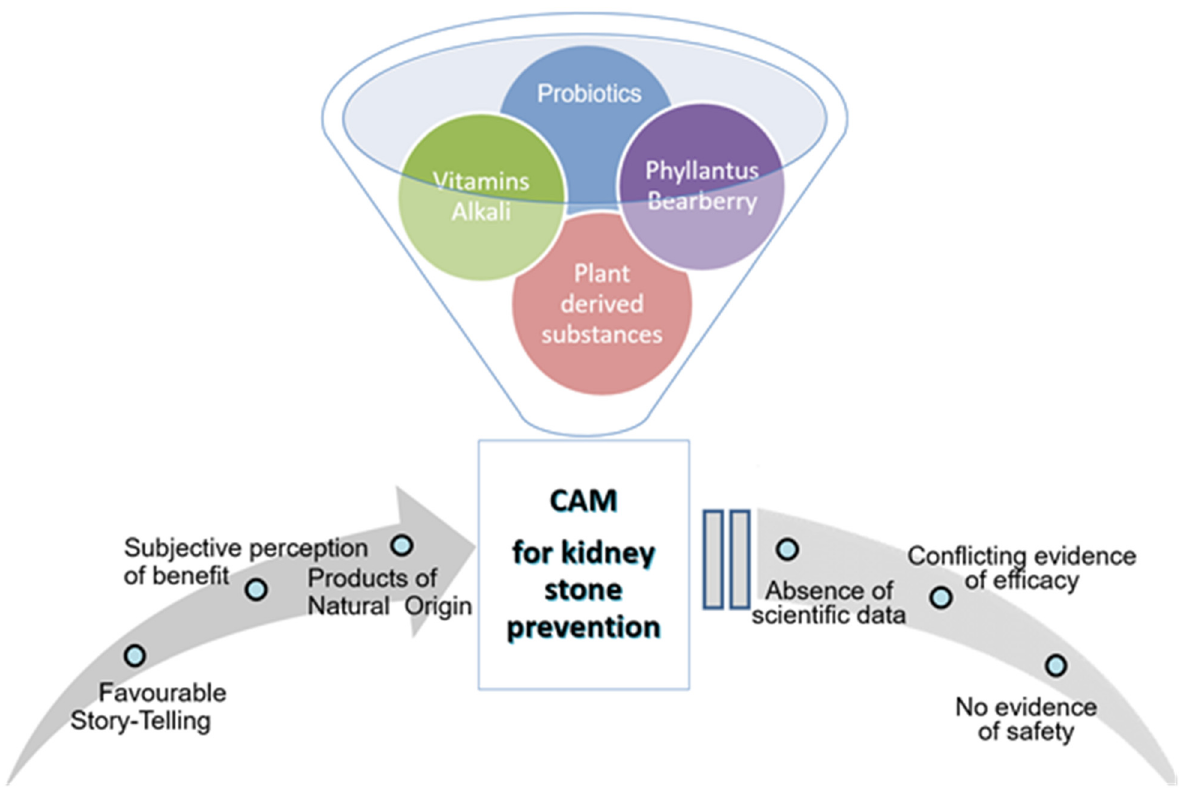
Figure 1. Complementary and Alternative Medicine (CAM) for kidney stone prevention: reasons for common use in presence of poor evidence-based recommendations.